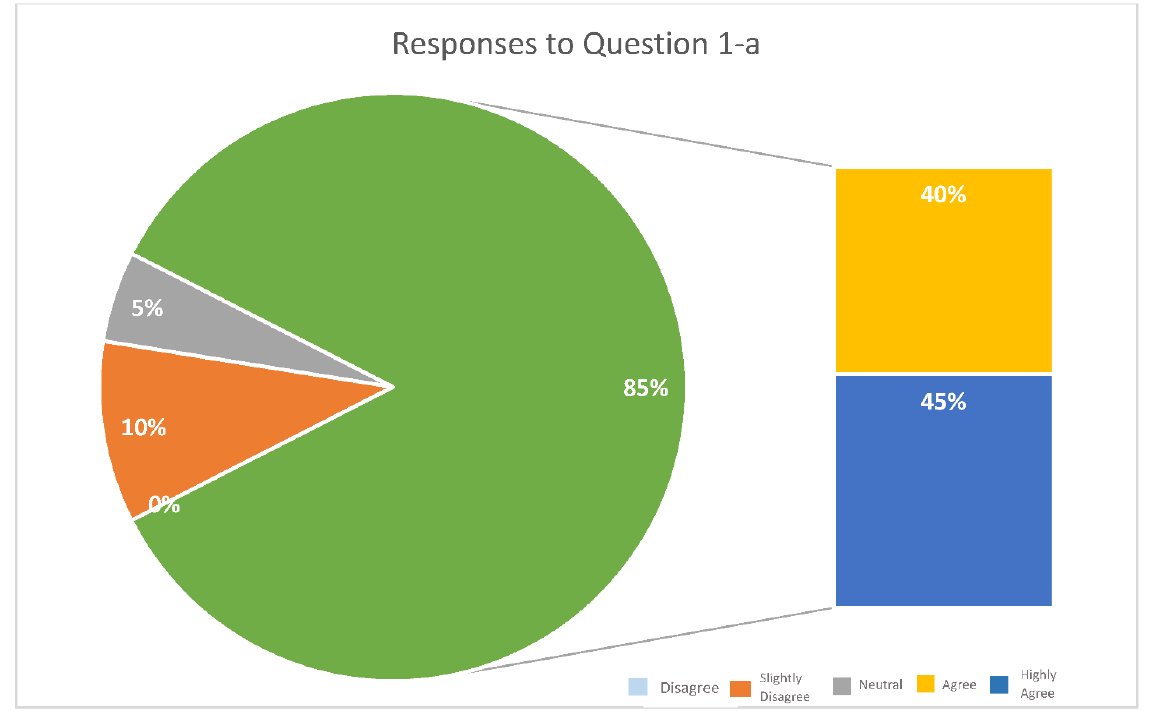
Figure 8. Responses to Question 1-a.